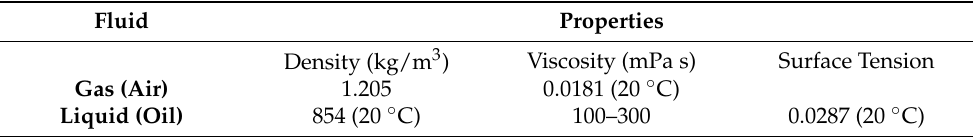
Figure 3. Variation of oil viscosity with temperature. Table 2. Properties of the experimental fluids.